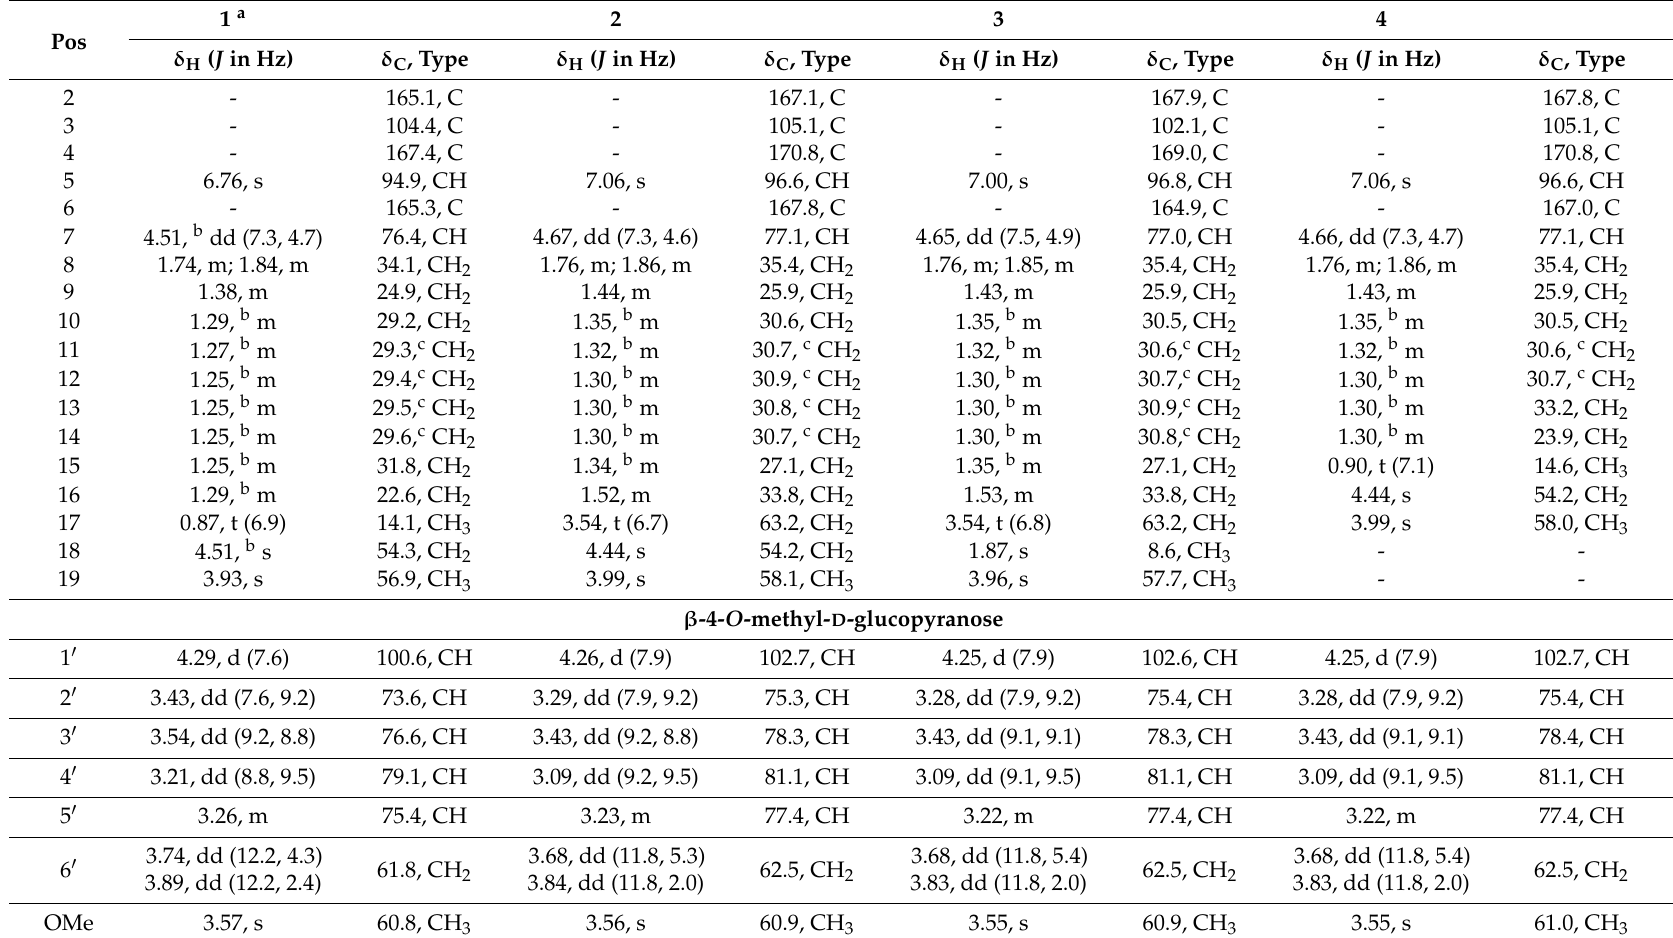
Table 1. 1 H- and 13 C-NMR data for akanthopyrones A–D ( 1 – 4 , Methanol- d 4